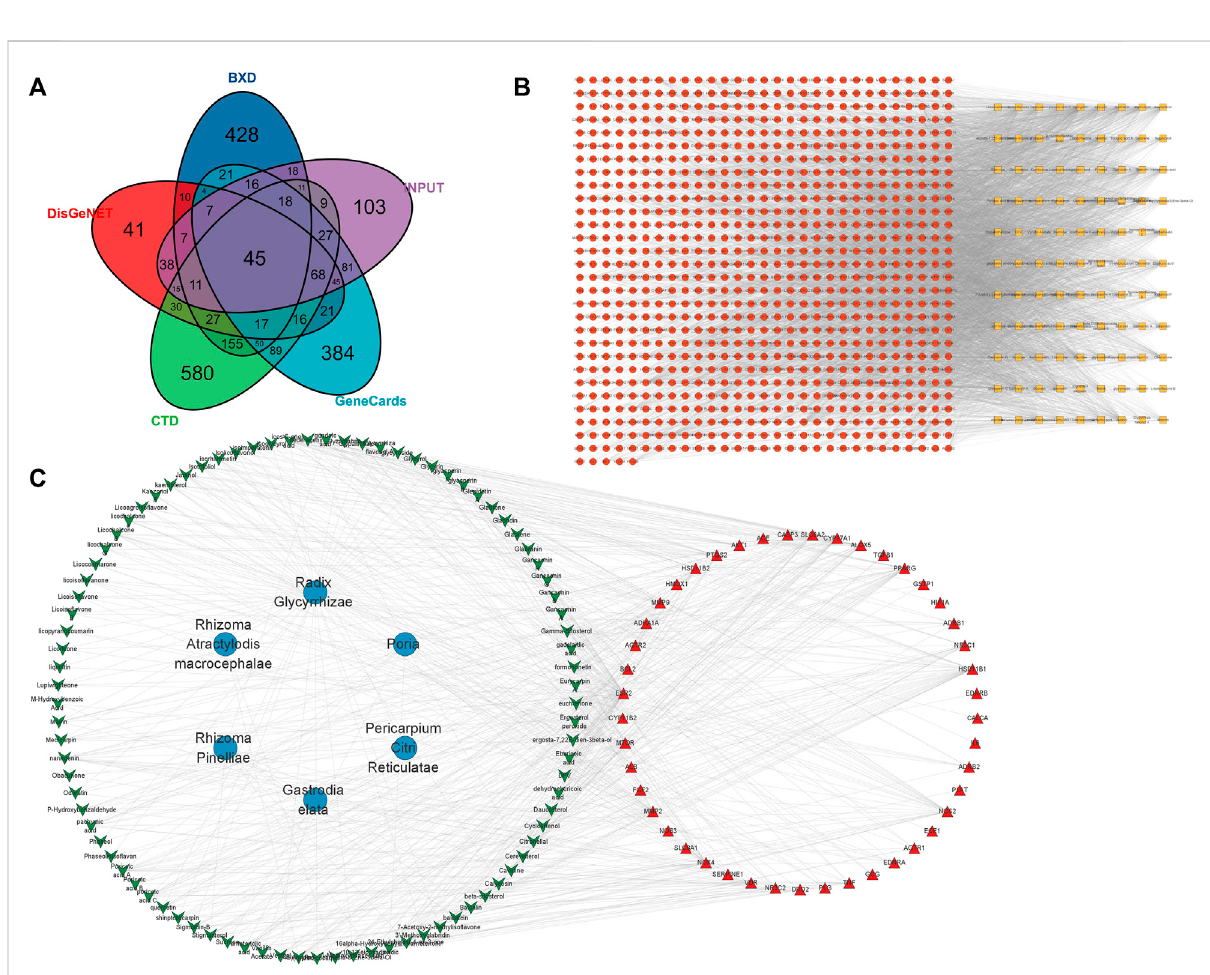
FIGURE 10 Network pharmacology of BXD and hypertension. (A) VENN of hypertension and BXD; (B) BXD-target network (C) BXD and hypertension